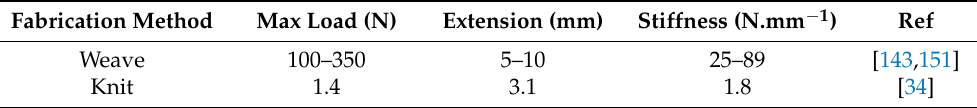
Summary of maximum load, extension, and stiffness of post-electro-compaction fabrication